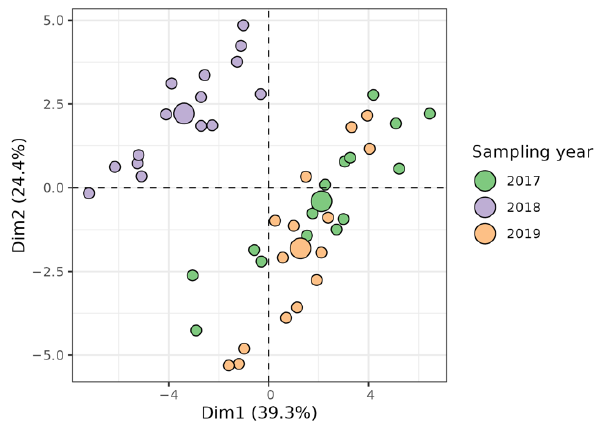
Figure 3. Principal component analysis (PCA) of three walnut cultivars (‘Bleggiana’, ‘Blegette’ and ‘Lara’) of three harvesting seasons, based on polyphenol composition, obtained from LC–MS/MS. The score plot shows the first two PCs, which account for 63.7% of the total variance, and a clear separation between the samples harvested in 2018 and the ones collected in 2019 and 2017. Large circles show the centroid of each sampling year cluster.